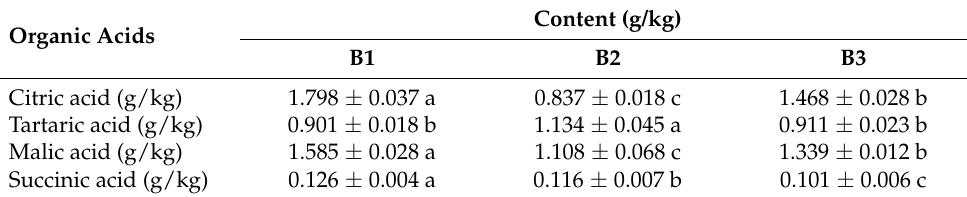
Table 1. Organic acids detected in berberis fruits. Organic Acids